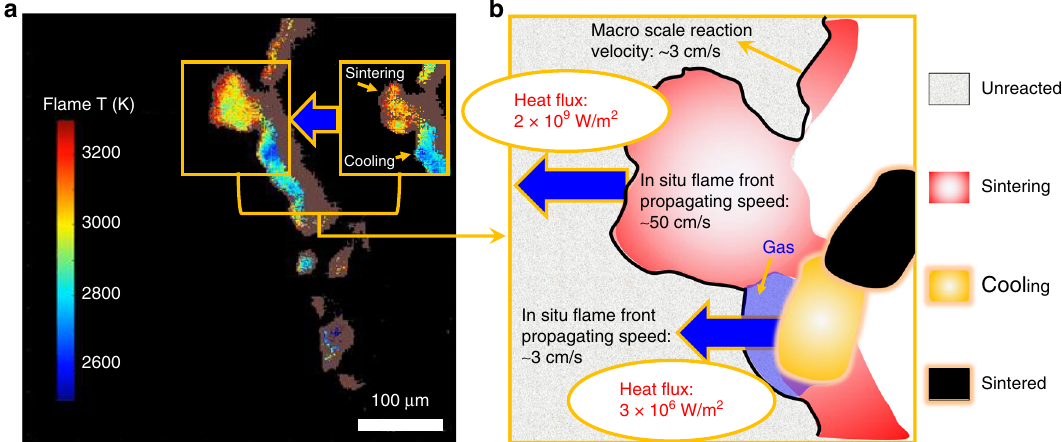
Fig. 5 Depiction of the proposed propagation mechanism and the role of reactive sintering. a Two typical temperature map snapshots of fl ame front of Al/ CuO nanothermite and b its schematic showing heat fl ux distribution from different stages of reactive sintering particles